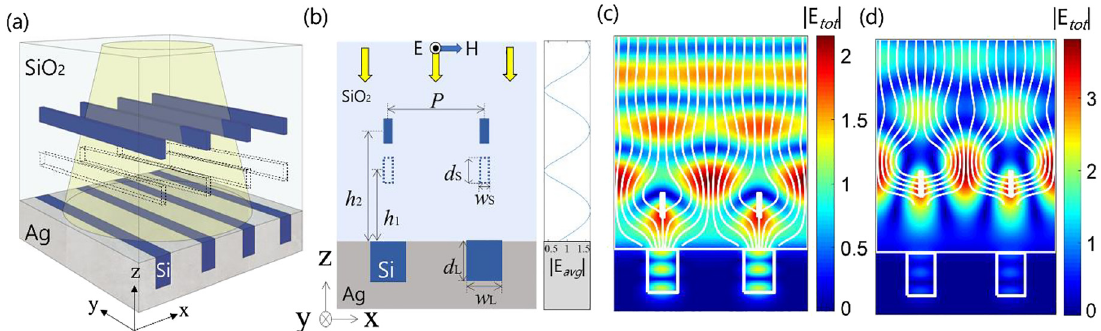
Figure 1: Vertically aligned metasurfaces that feature switched coupling of incident light for y -directed polarization. (a) Schematic of integrated metasurfaces composed by the arrays of two different types of nanobeams. Nanobeams at the bottom are entrenched into metal reflector and nanobeams at the top are percolated into silica superstrate for experimentally realizable scheme with backside illumination. (b) Cross-sectional image of nanobeam array with 100-nm-width ( w L ), 140-nm-height ( d L ) for bottom nanobeams and 10-nm-width ( w s ) and 80-nm-height ( d s ) for top nanobeams. The nanobeams are laterally separated by the period of 320 nm that is less